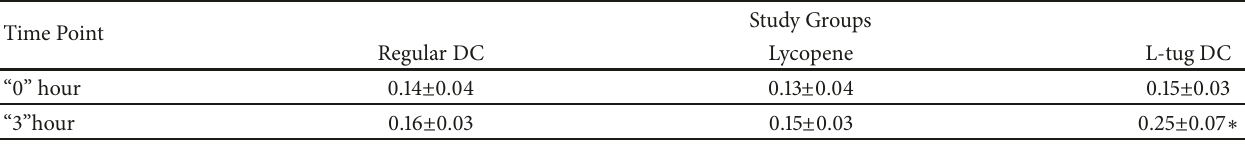
Table 2: Serum lycopene concentration ( 𝜇 g/ml) in volunteers at 3 rd hour after ingestion L-tug DC (averages ± SD).